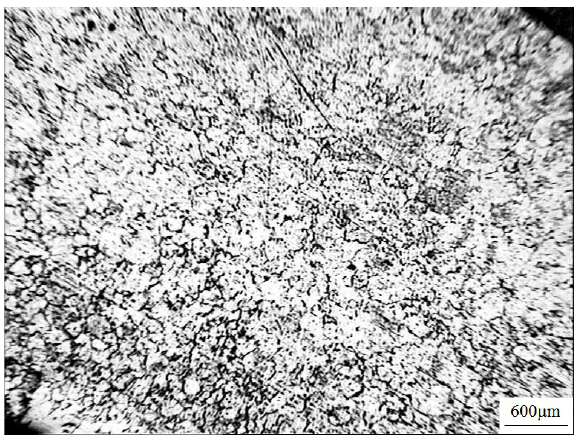
Figure 2. Microstructure of the specimen quenched without the PEF treatment (cid:2) 50 .